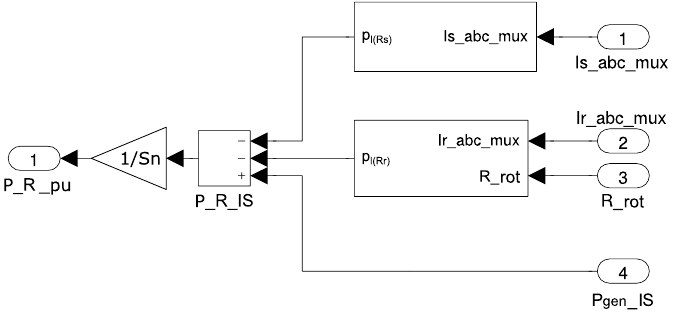
Figure 14. Rotor and stator power losses